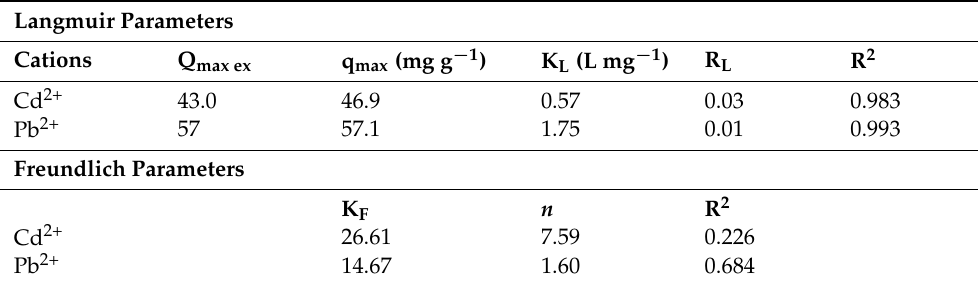
Table 2. Adsorption isotherm parameters for the Langmuir and Freundlich models. Langmuir